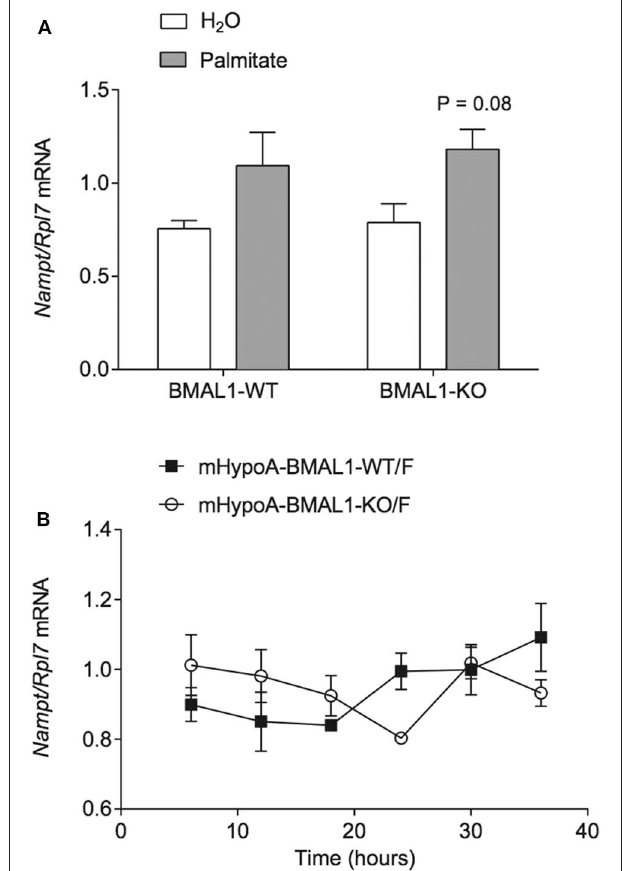
FIGURE 2 | BMAL1 does not mediate the induction of Nampt by palmitate nor rhythmic NAMPT expression. (A) mHypoA-BMAL1-WT/F and mHypoA-BMAL1-KO/F cells were treated with 50 µ M palmitate for 24h and assessed for changes in Nampt mRNA. (B) mHypoA-BMAL1-WT/F and mHypoA-BMAL1-WT/F-BMAL1-KO/F cells were serum-starved for 12h and synchronized for 30min with 20 µ M forskolin in DMEM containing 5% FBS. Fresh media containing 5% FBS was then applied, indicating t = 0h. Cells were first harvested at 6h, then every 6h until 36h. Nampt mRNA levels were assessed by qRT-PCR. n = 4 independent experiments. Data are expressed as mean ± SEM. Statistical analysis was performed by two-way ANOVA with the Tukey post hoc